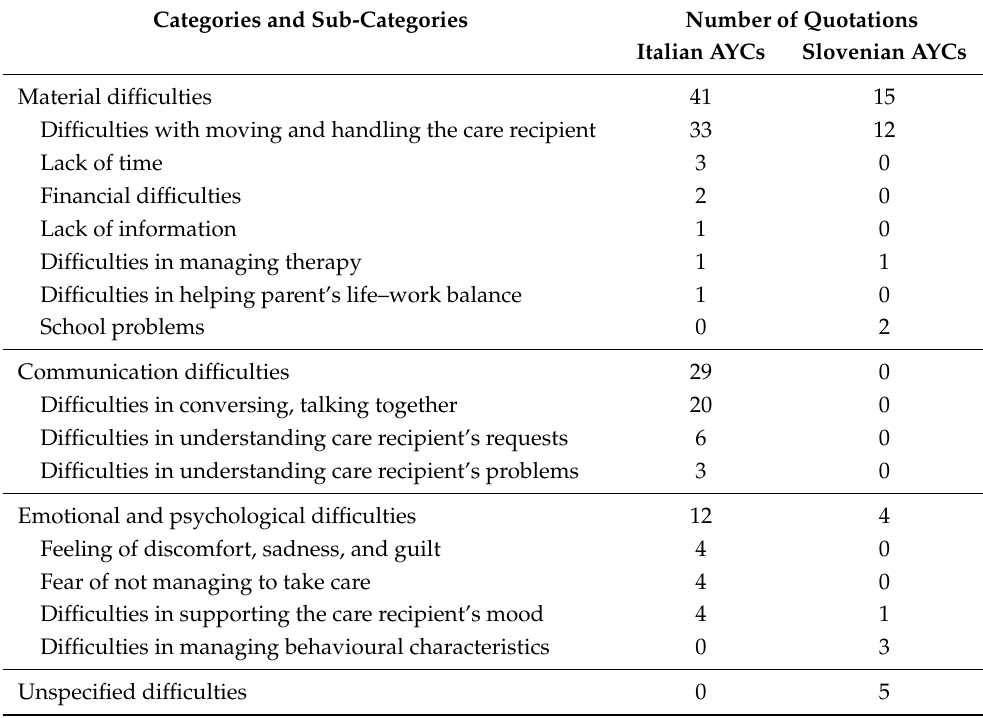
Table 5. Categories and sub-categories related to difficulties encountered by AYCs of GrPs. Categories and